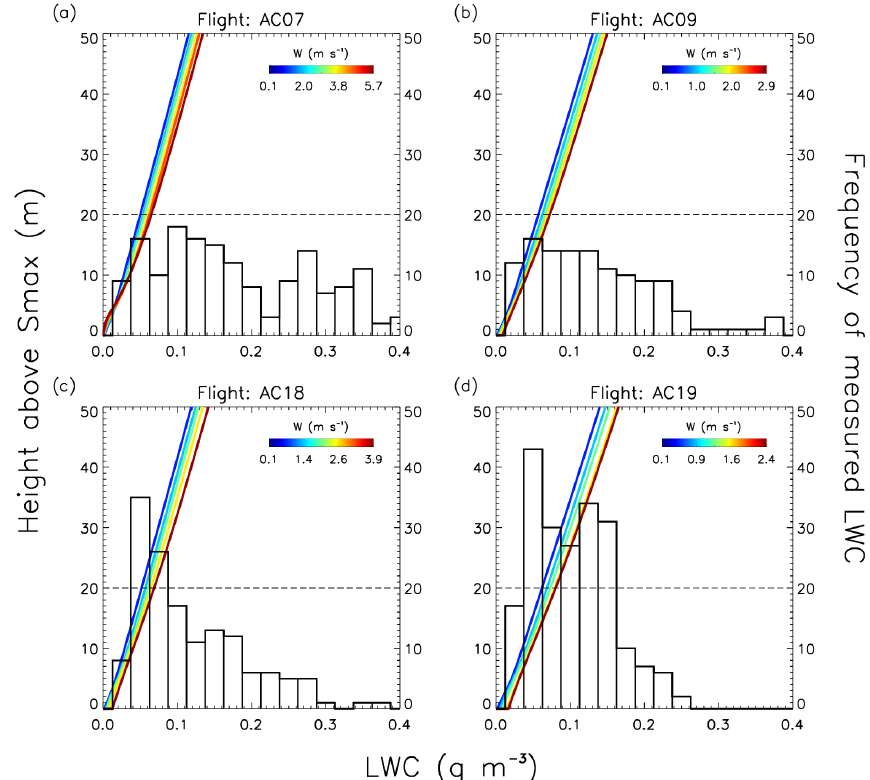
Figure 3. Predicted LWC [gm − 3 ] as a function of height above the level of S max (left axis) and w (lines, color-coded by w [ms − 1 ]) for flights (a) AC07, (b) AC09, (c) AC18, and (d) AC19. The vertical bars indicate the number of cloud passes (with a temporal resolution of 1s) as a function of the measured LWC by CAS-DPOL and CCP-CDP in cloud (right axis). The dashed line denotes the level of 20m above predicted maximum supersaturation, at which N d,p is predicted (Sect. 3.2.2).